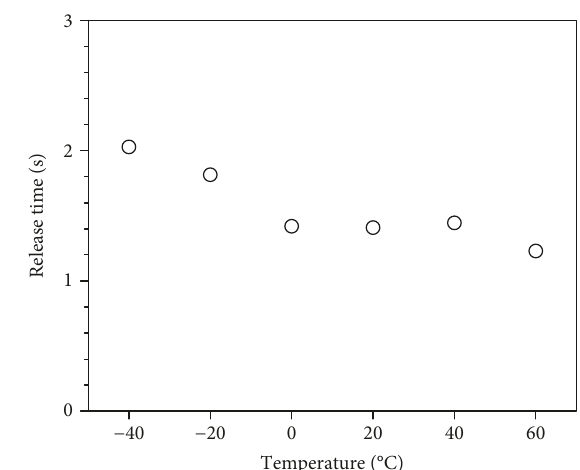
Figure 11: Release times of each solar panel as a function of the number of cable windings for an input voltage of 8V.